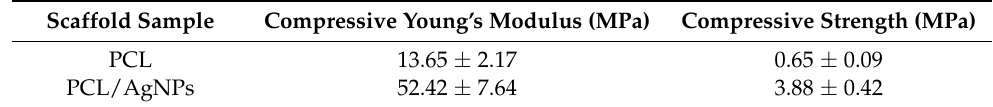
Figure 11. Representative compressive stress–strain curves of the 3D-printed PCL and PCL/AgNPs scaffolds. Table 4. Compressive Young’s modulus and compressive strength at 10% strain of the PCL and PCL/AgNPs